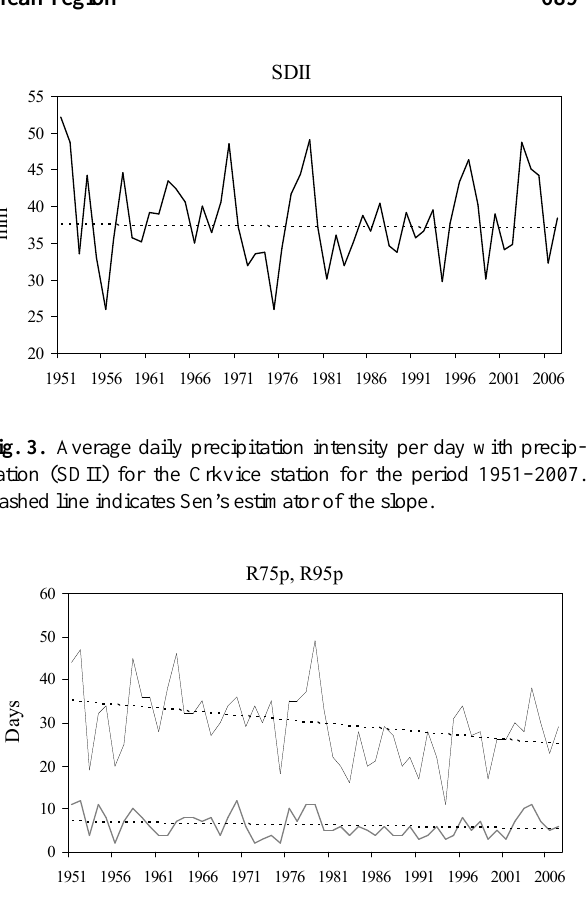
Fig.4. Number of days with Rd>75th (R75p in black) and Rd>95th (R95p in gray) percentile for the Crkvice station for the period 1951-2007. Dashed line indicates Sen’s estimator of the slope.